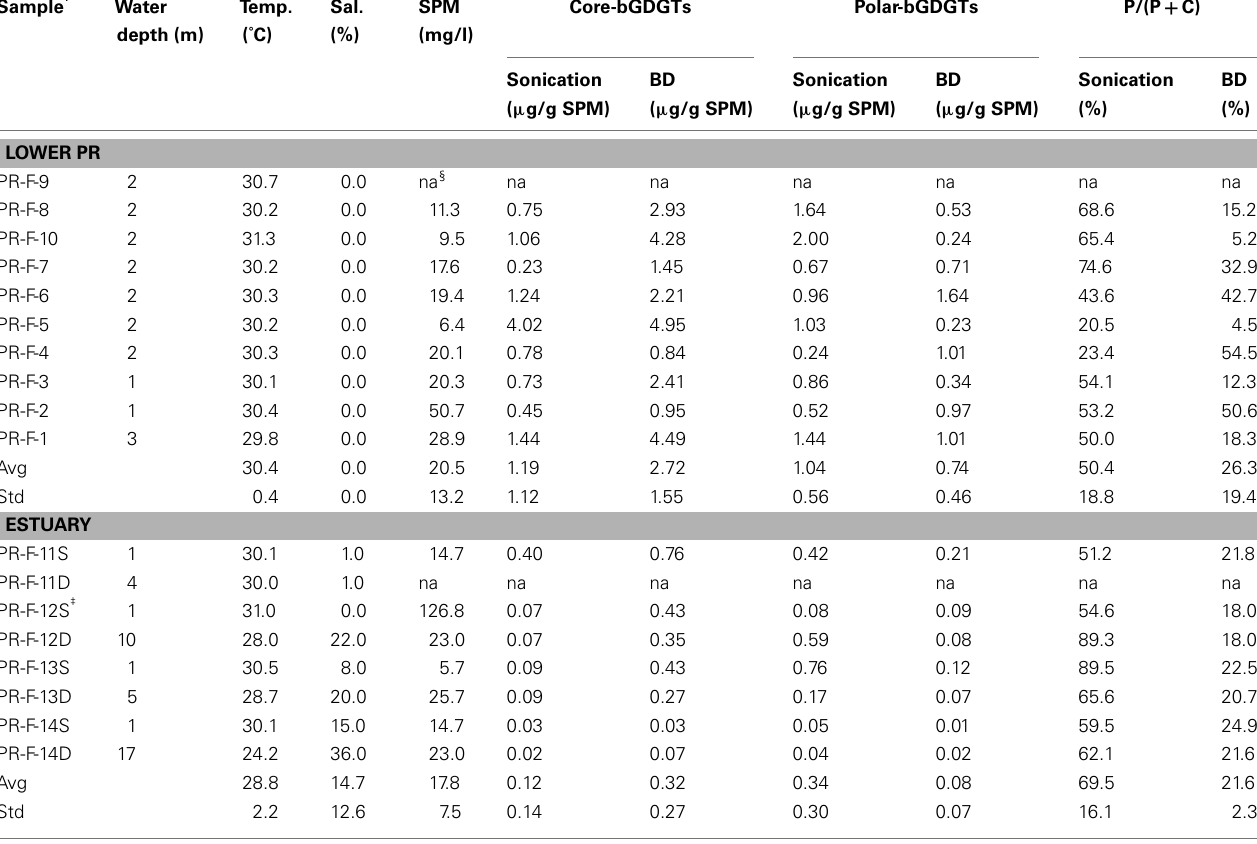
bGDGTs, branched glycerol dialkyl glycerol tetraethers. Core (C)-bGDGTs and polar (P)-bGDGTs are presented for two extraction methods: sonication and Bligh and Dyer (BD). † PR-F, Pearl River-filter, which is followed by station number (solid circle in Figure 1 ); the letter “S” or “D” after station number means “surface” or “deep,” respectively. ‡ This sample was collected at the front of Xijiang water in the estuary and was excluded from the calculation of average values for the estuary samples. § Not